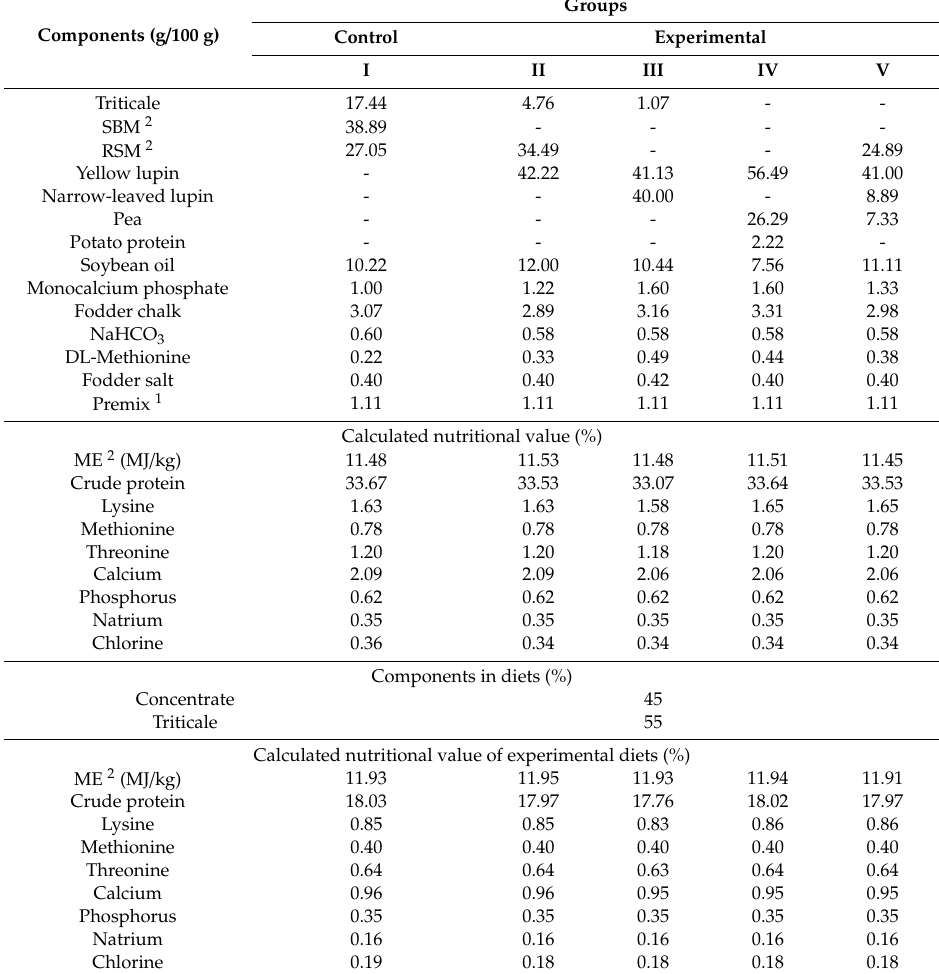
Table 3. Concentrates used in the second phase of duck